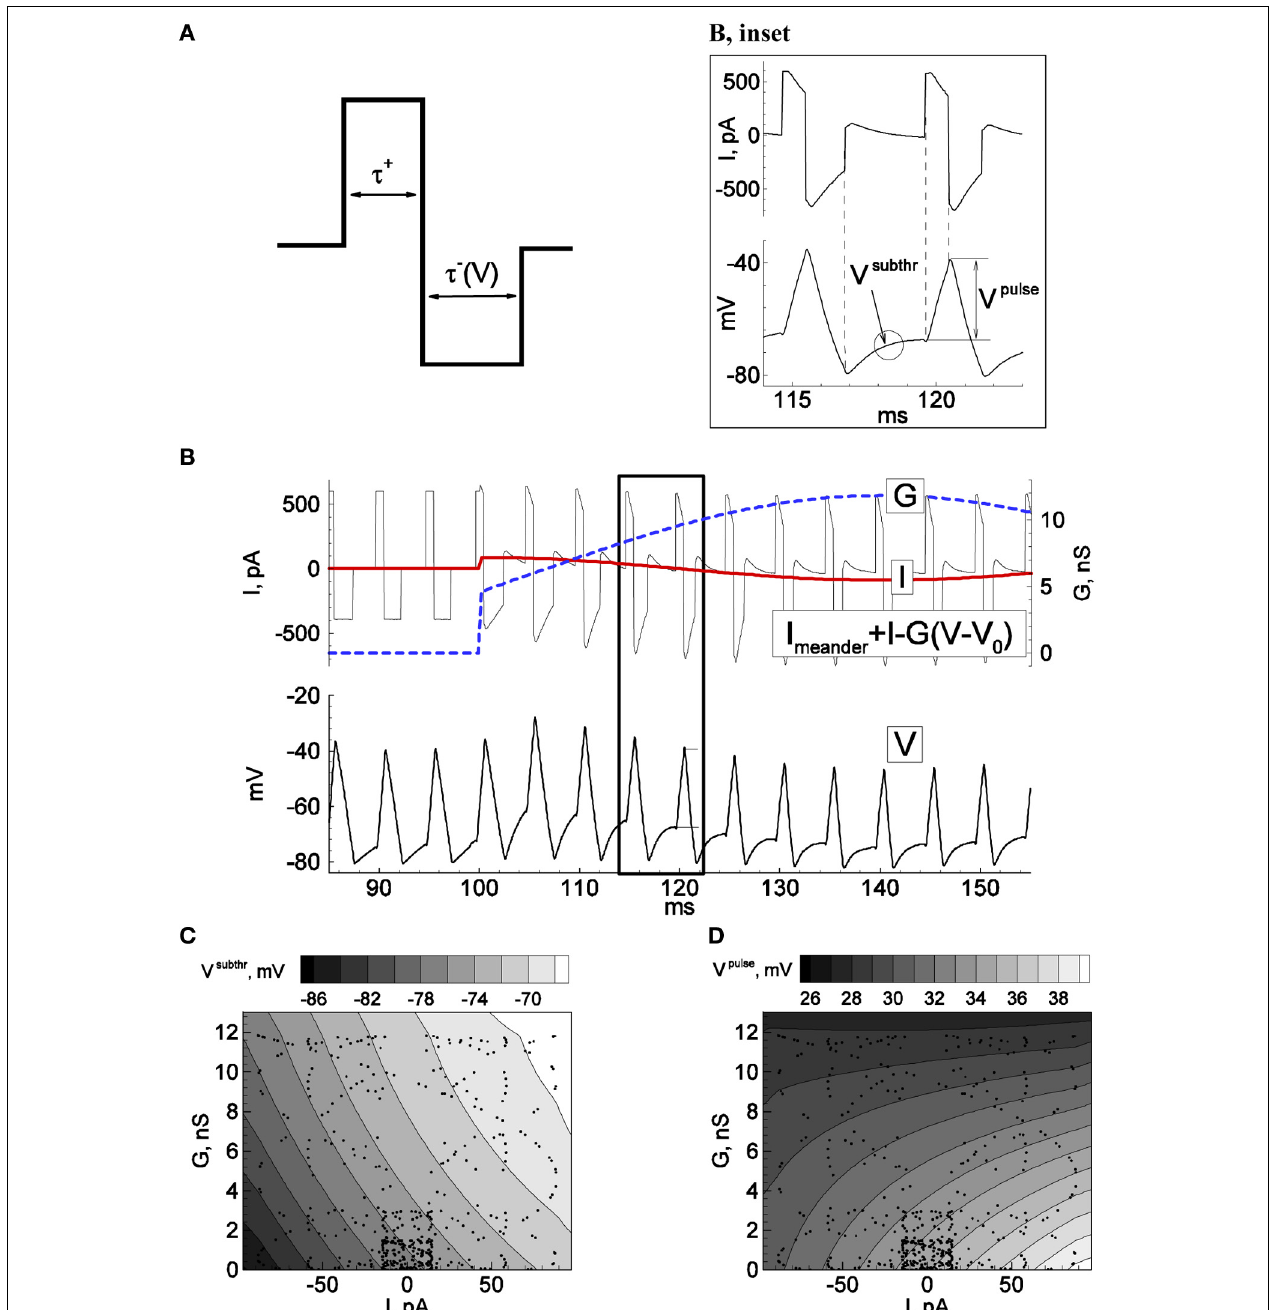
FIGURE 1 | Principle of firing-clamp technique for conductance estimation: Calibration procedure. Recordings from an MPN neuron were performed in perforated-patch configuration. By means of real-time computer control (“firing-clamp”) the voltage-dependent meander-wise current shown in (A) was repeatedly injected at a maintained rate, 200Hz, which evoked probe spikes ( B , bottom). The positive and negative pulse amplitudes of the meander were 0.4 and –0.3nA , respectively. The positive pulse duration τ + was fixed at 0.81ms, and the negative pulse duration τ − ( V ) was controlled by the recorded membrane voltage, with pulse termination when the voltage